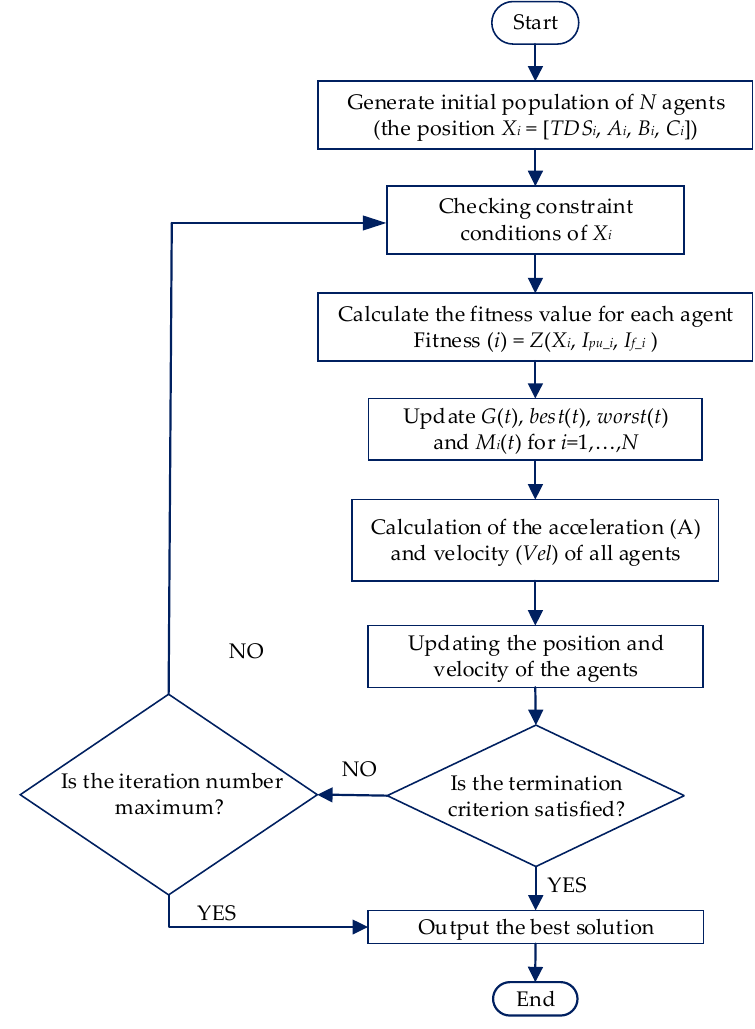
Figure 6. A flow chart of GSA applied to the ASPC approach of